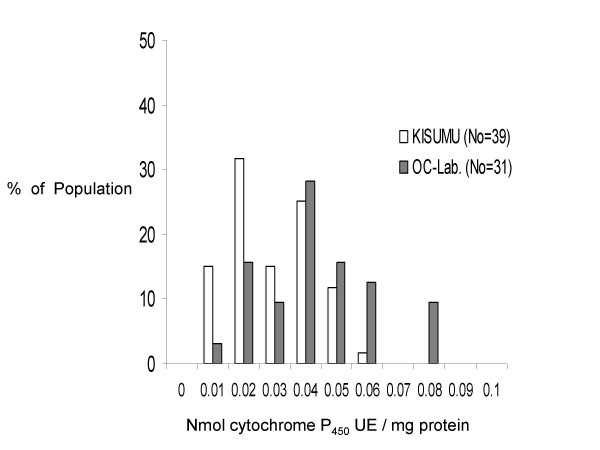
Oxidase levels in Kisumu and OCEAC laboratory strains of Anopheles gambiae s.s. through biochemical assays. KISUMU: Pattern of cytochrome P450 UE/mg protein in individuals of the Kisumu susceptible laboratory strain, OC-Lab: Pattern of cytochrome P450 UE/mg protein in individuals of the OCEAC laboratory strain.